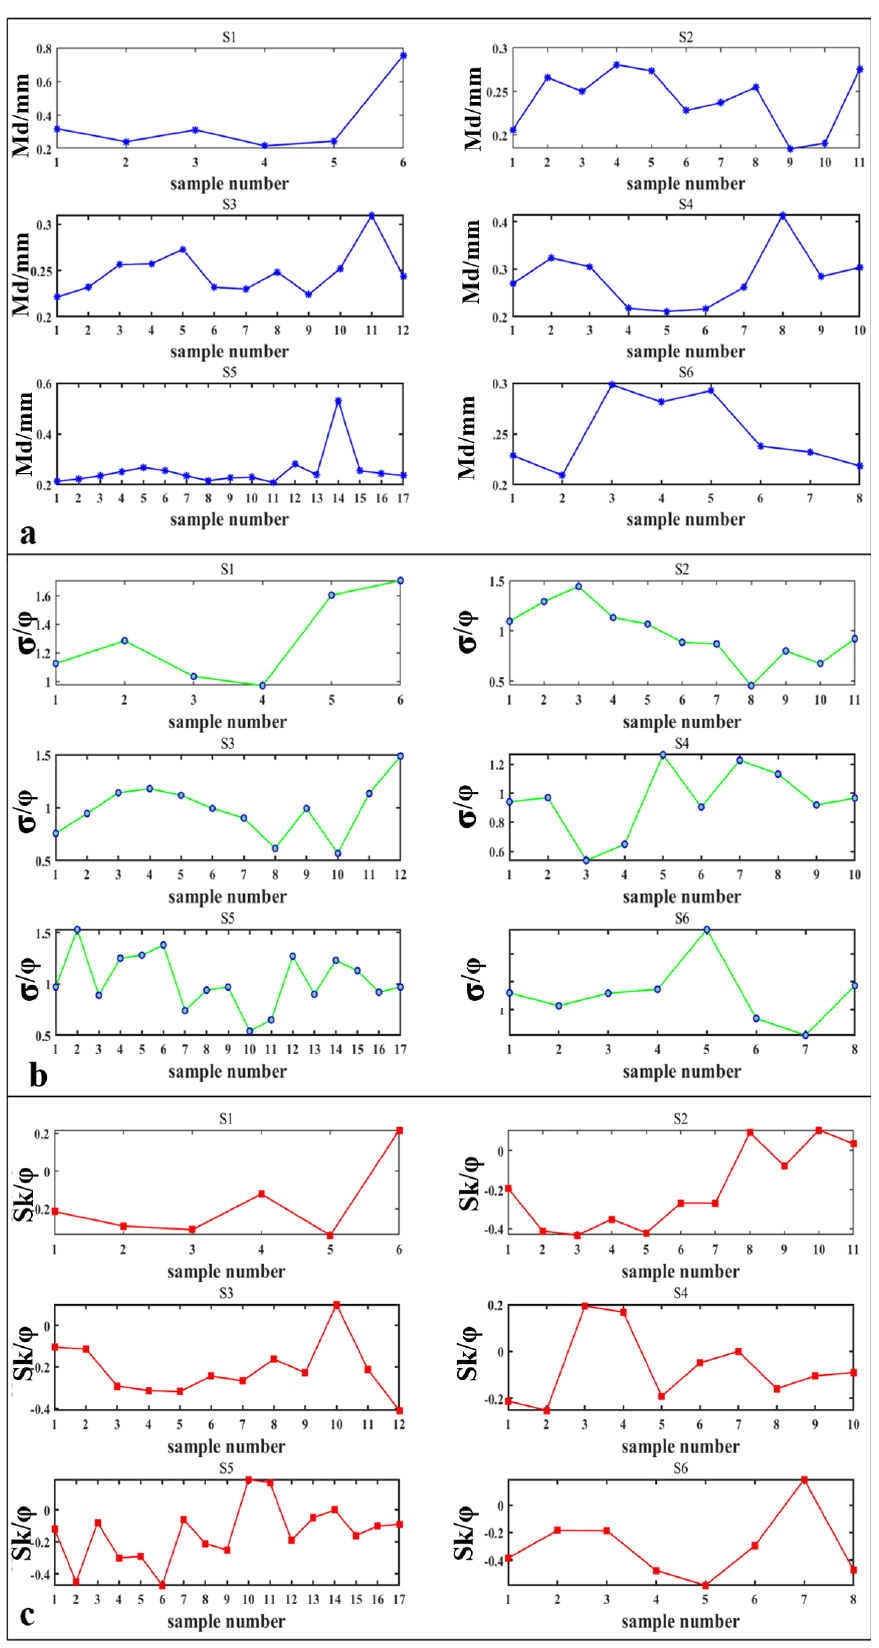
Figure A1. Distribution of parameters for sediment particle size along the path. ( a – c ) depict the median particle size, the sorting coefficient and the skewness coefficient of all samples along the six